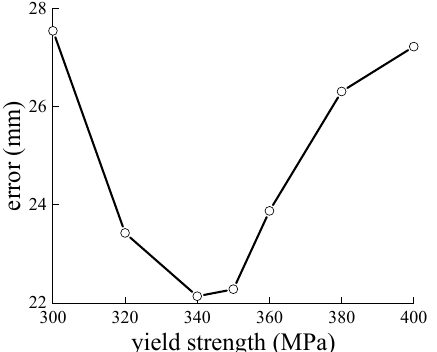
Figure 10. Relation between the error and yield strength.